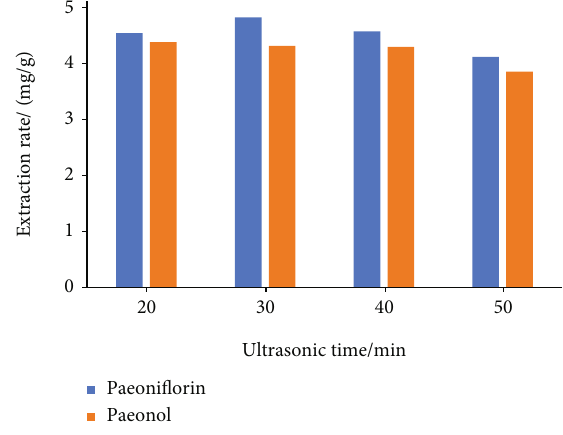
Figure 6: E ff ect of ultrasonic time on Moutan Cortex extraction e ffi